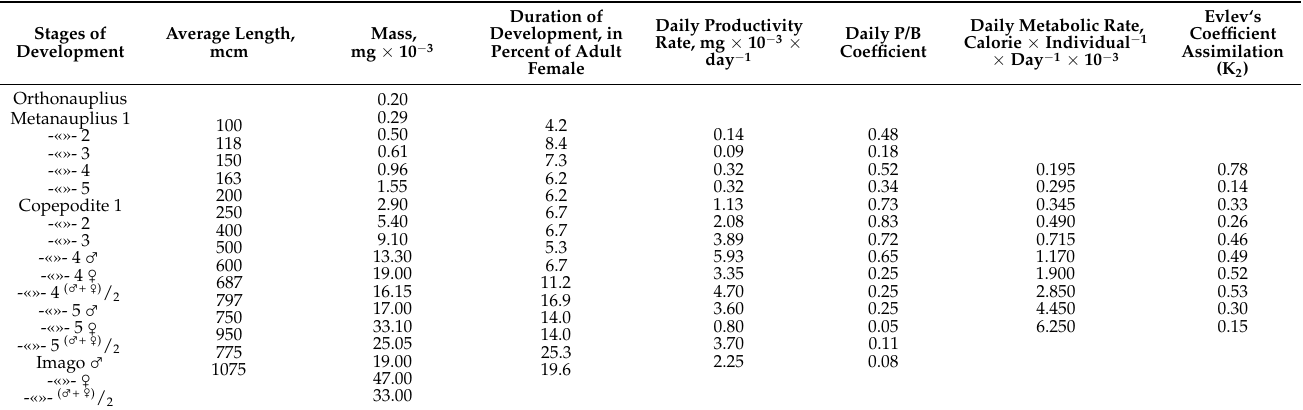
Table 2. Development, growth and productivity parameters of A. vernalis (Fischer, 1853) in the Volga Delta river (Russia). Adult female duration of development at 20 ◦ C = 17.8 days ± 1.5.